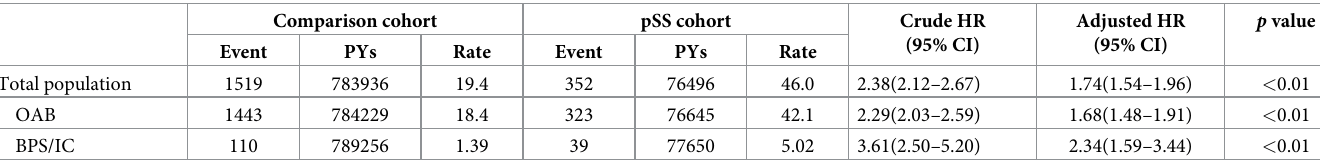
Table 2. Risks of OAB and BPS/IC among pSS and comparison